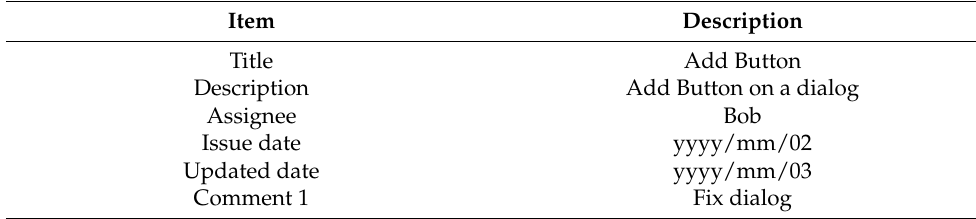
Figure 3. High-level chart of flow of steps in our method. Table 1. Example of items described in an issue